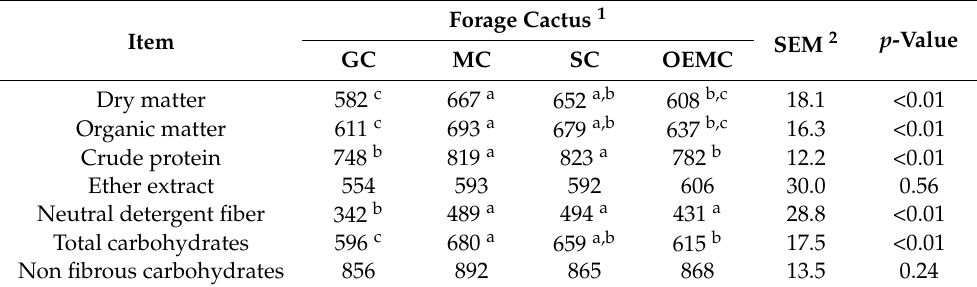
Table 4. Effects of forage cactus genotypes on apparent digestibility of dietary chemical components (g/kg; n =